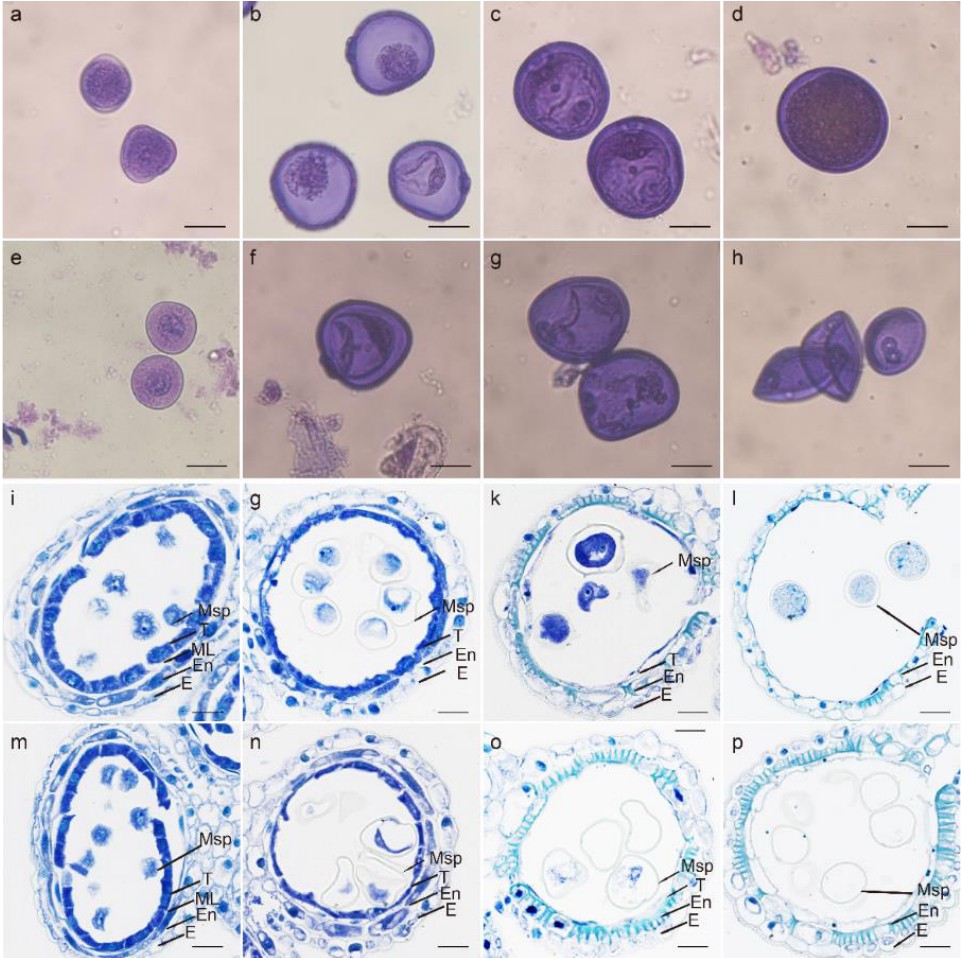
Figure 7. The microspores and anthers at different developmental stages. Microspores at early uninucleate stage ( a and e ), vacuolated stage ( b and f ), binucleate stage ( c and g ), and mature pollen stage ( d and h ). Wheat anther at early uninucleate stage ( i and m ), vacuolated stage ( g and n ), binu- cleate stage ( k and o ), and mature pollen stage ( i and p ). ( a – e ) and ( i – l ), pollens and anthers of control-treated BS366; ( e – h ) and ( m – p ), pollens and anthers of cold-treated BS366; E, epidermis; En, endothecium; ML, middle layer; Msp, microspores; T, tapetum; bars in ( a – h ) 20 μm; bars in ( i – p ) 50 μm.